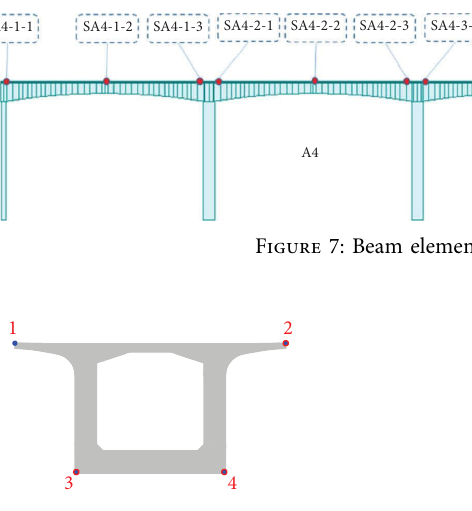
Figure 8: Finite element stress calculation output point.